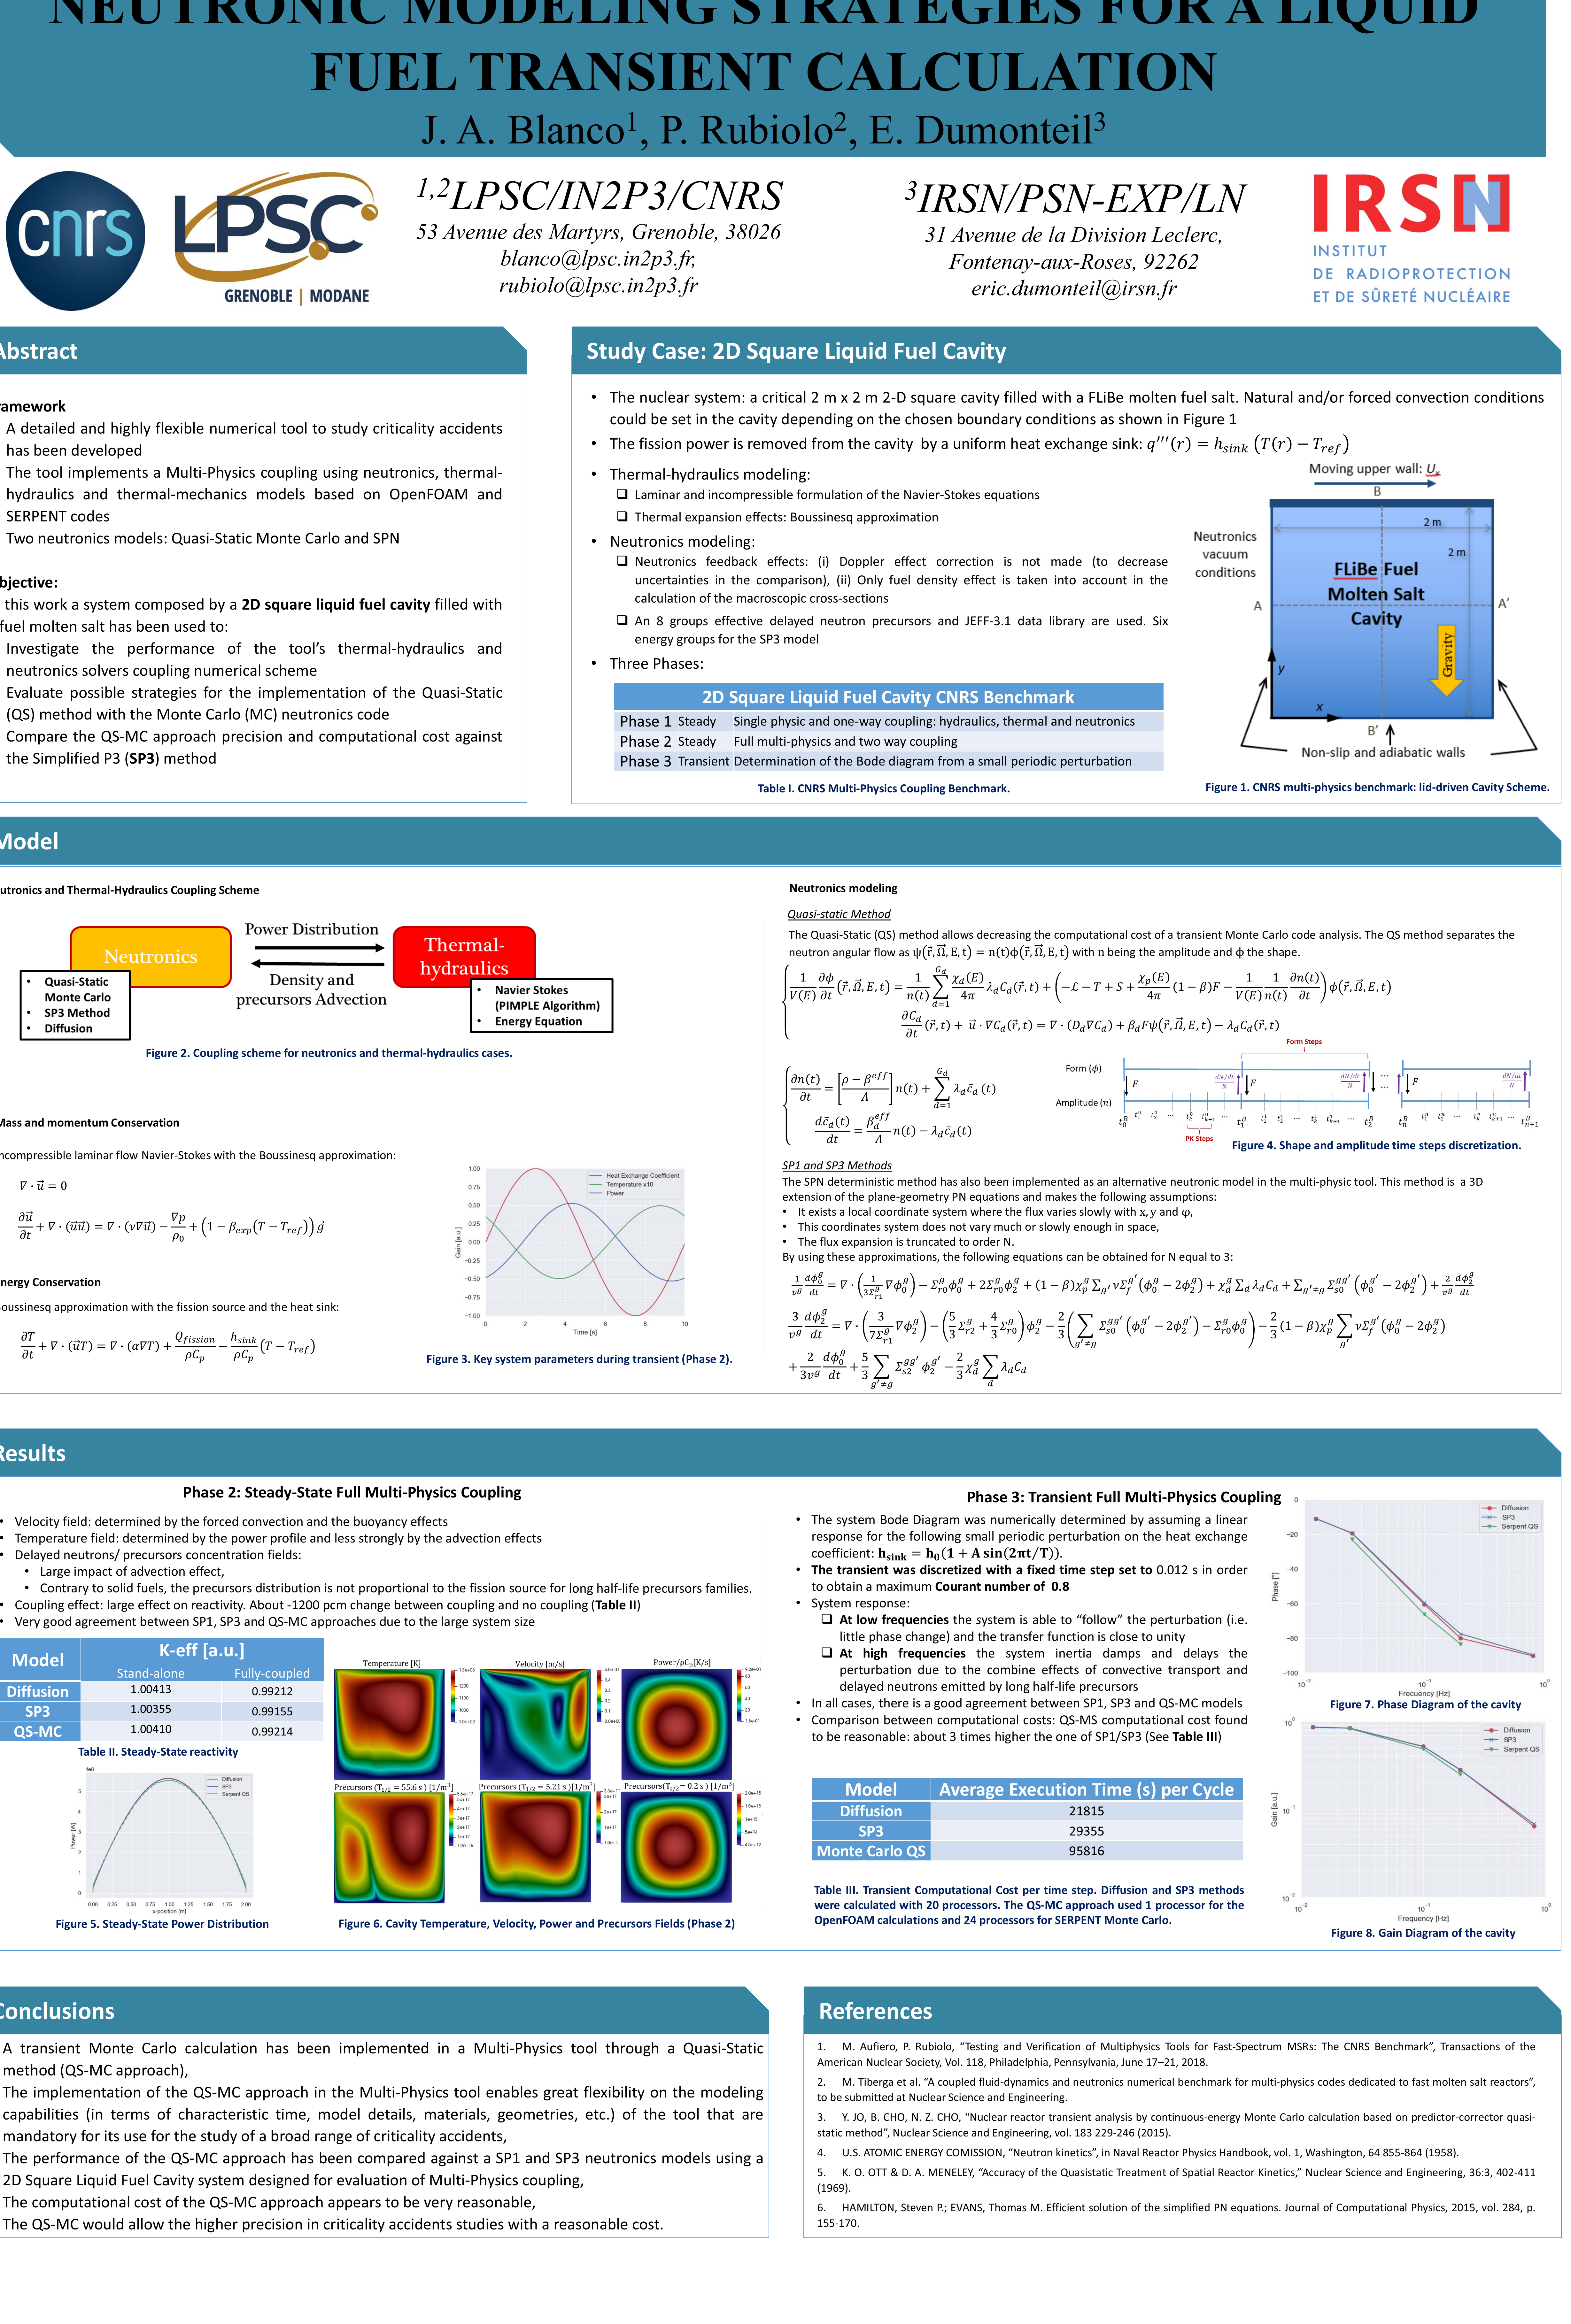
Figure 5. Steady-State Power Distribution Figure 6. Cavity Temperature, Velocity, Power and Precursors Fields (Phase